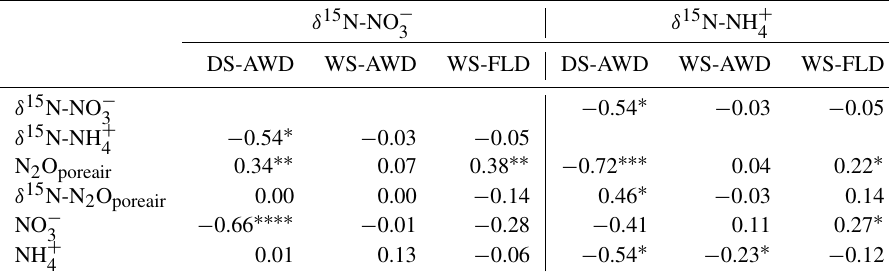
Table 4. Spearman correlations between δ 15 N-NO − NH + concentrations in the three water management treatments (WS-FLD: water-seeding + conventional flooding; WS-AWD: water- 4 seeding + alternate wetting and drying; DS-AWD: direct dry seeding + alternate wetting and drying).